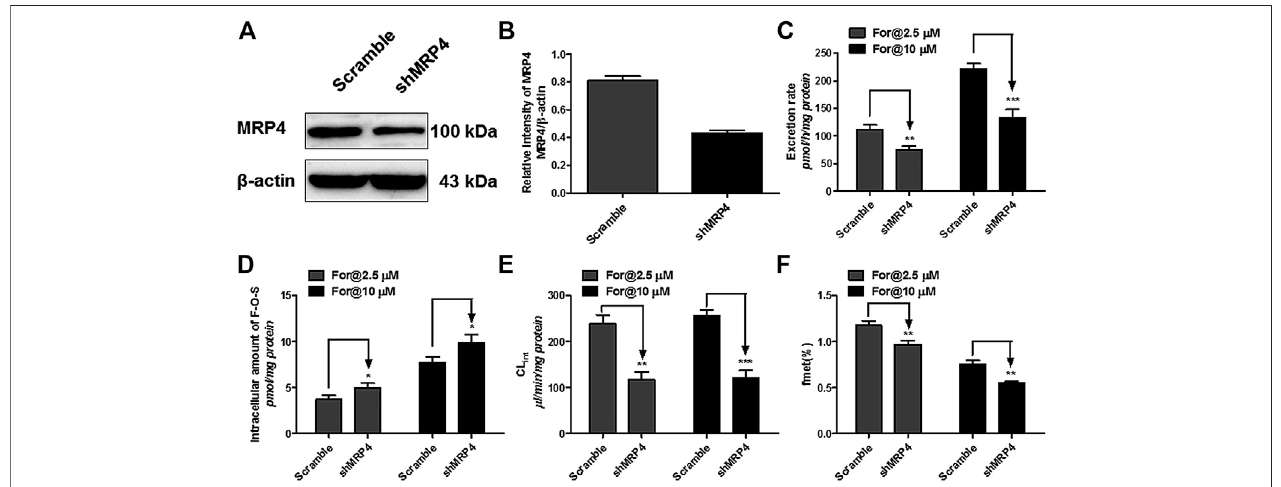
FIGURE 9 | Effect of MRP4 silencing on formononetin (2.5 and 10 μ M) disposition in HEK-SULT1A3 cells. (A) Western blot of MRP4 after transient transfection by selectedshRNA. (B) EffectsofgenesilencingontheproteinlevelofMRP4. (C) Effectsofgenesilencingontheexcretionratesofformononetinsulfate. (D) Effectsofgene silencingontheintracellularamountsofsulfate. (E) Effectsofgenesilencingontheexcretionratesofsulfate. (F) Effectsofgenesilencingonthecellularsulfonation(f met )of formononetin. * p < 0.05, ** p < 0.01, *** p < 0.001 compared with control. Each data point was shown as mean ± SD (n (cid:1) 3).